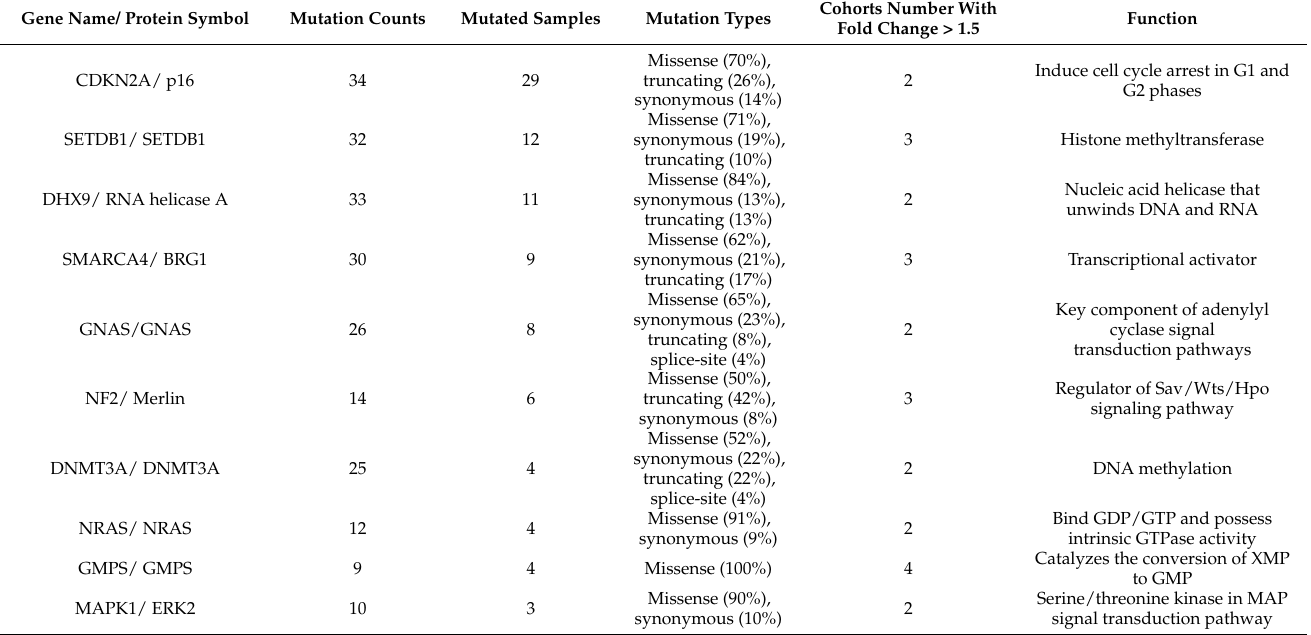
Table 2. Ten potential TAA targets were identified from seventy-five driver